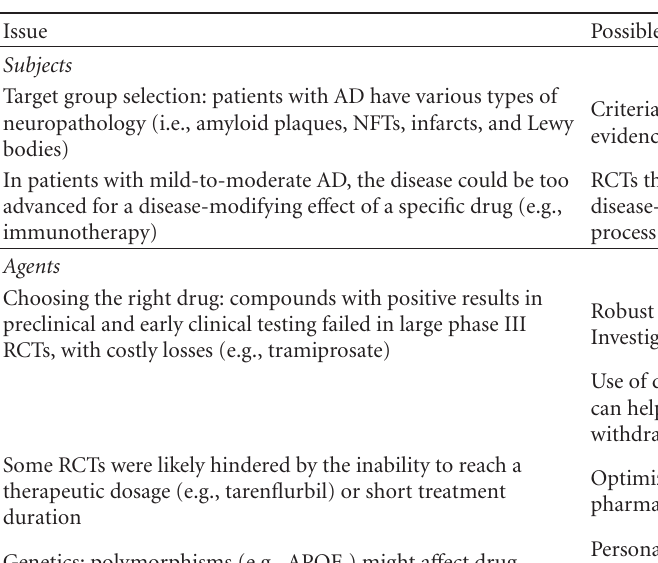
Table 1: Issues of RCTs of